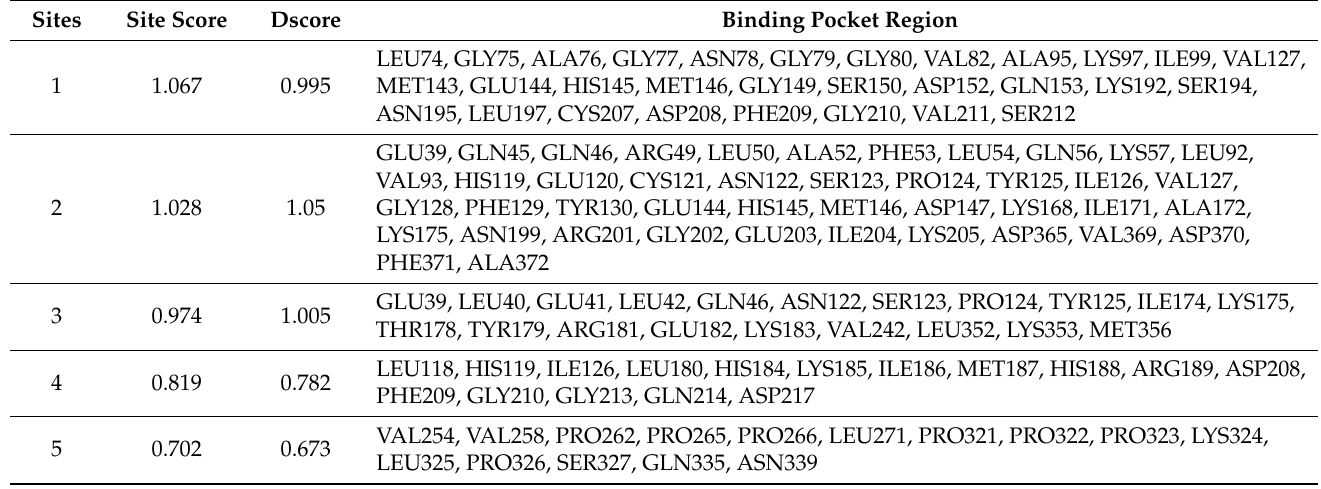
Table 1. The top five binding sites of MEK1 receptor predicted by